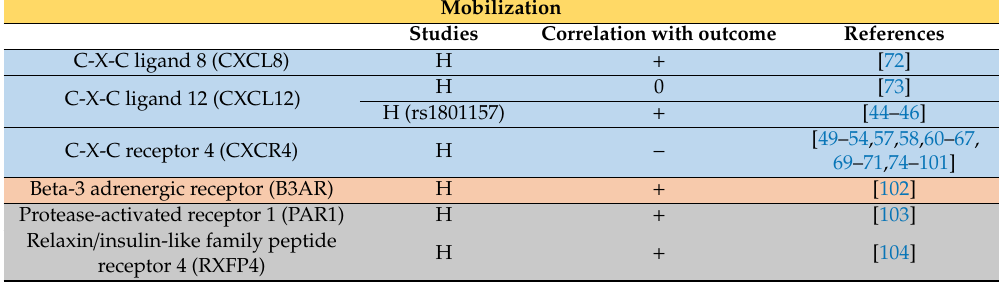
Table 1. Mobilization in human (H) studies. Mobilization is measured by the number of circulating CD34 + (HSC) and / or nucleated blood cells harvested using leukapheresis. See the Methods section regarding the reporting of results (Section